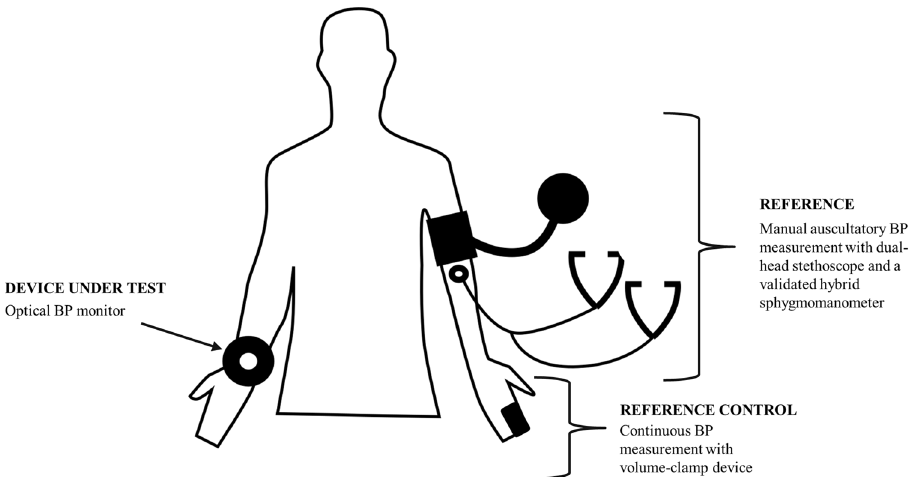
Figure 3. Experimental set up of the required equipment to investigate the performance of a BP monitor intended to be used in 24/7 environments. Reference BP values are obtained by a validated hybrid sphygmomanometer and auscultation with a dual-head stethoscope. Changes in auscultation values with different body positions are controlled by the continuous measurements of an ipso-lateral volume-clamp device. Measurements by the device under test are performed in the contra-lateral